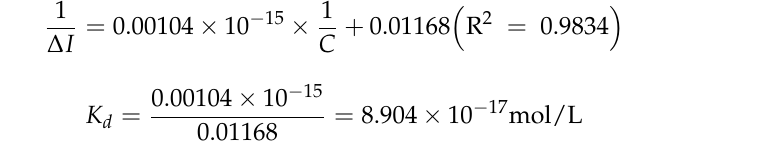
Figure 7. ( A ) Structures of GPER ligand compounds; 3D schematic diagram of molecular docking between GPER and fi ve estrogens and their analogs: ( B ) The residues Arg299 and Glu115 showed hydrogen bonding interactions with resveratrol with an interaction distance of 2.4 Å and 2.3 Å; ( C )